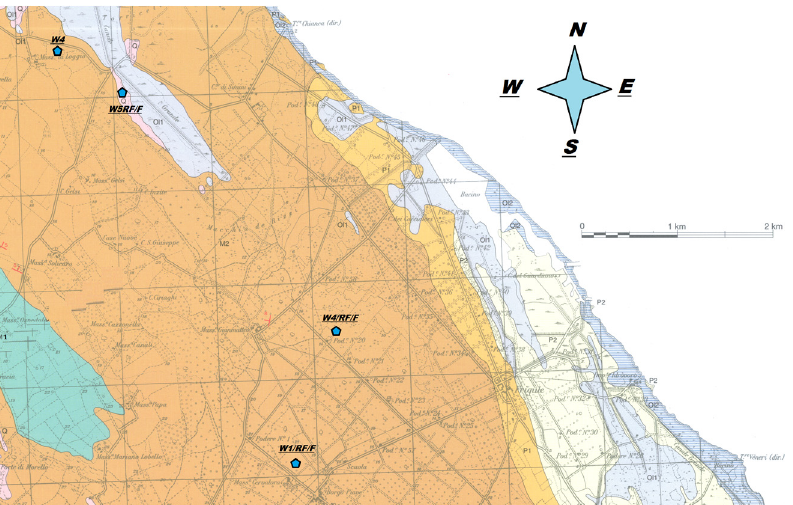
Figure 8. Geological map of the Acquatina di Frigole area (adapted from [114]). M1: Pietra Leccese (Miocene); M2: Andrano Calcarenite (Upper Miocene); P1: Leuca Breccia (Lower Pliocene); P2: Uggiano La Chiesa Formation (Pliocene); ol1: marsh deposits (recent); ol2: sands (recent). Location of the four boreholes in Figure 8 is also shown.